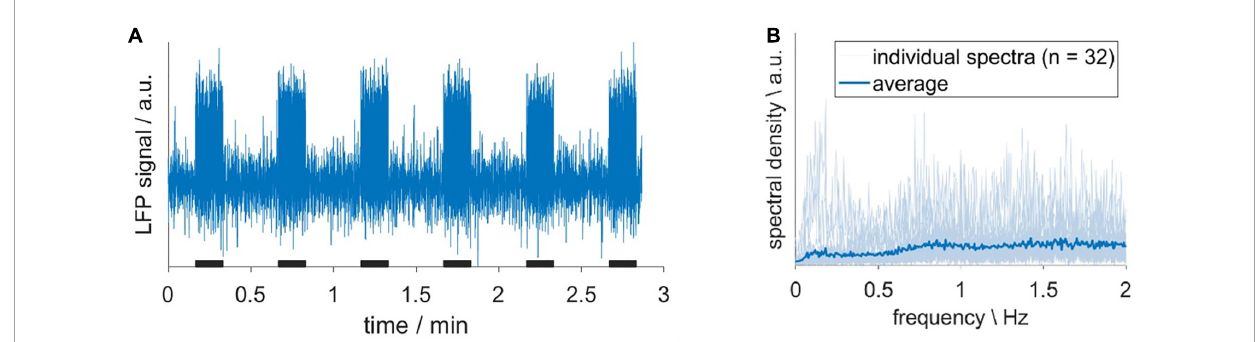
FIGURE7 Hemodynamic oscillations do not have a direct neuronal correlate. (A) Exemplary LFP recording, acquired upon sensory stimulation with 10-s long stimulation periods (black bars). (B) Individual spectra (light blue) and their average (dark blue). The absence of a prominent peak around 0.2 Hz indicated that no oscillations were